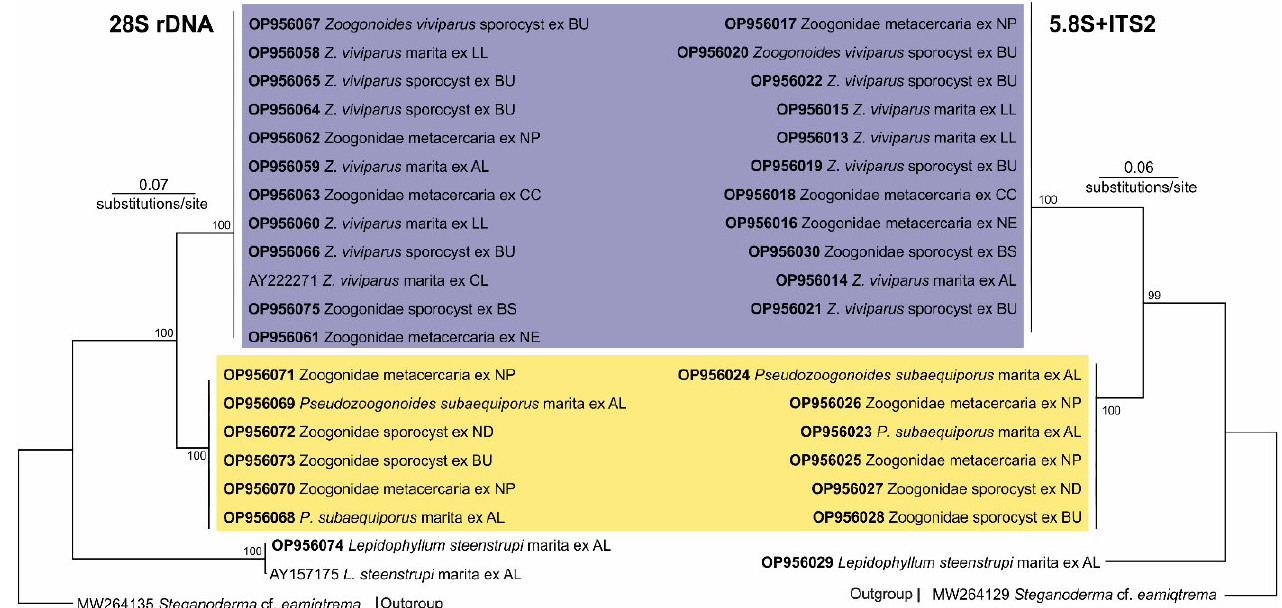
Figure 1. Maximum likelihood phylogenetic trees based on the 28S and 5.8S+ITS2 rDNA sequence data. Bootstrap values are printed in nodes. GenBank accession numbers of newly generated se ‐ quences are indicated in bold. Blue and yellow squares mark life cycle stages of Zoogonoides viviparus and Pseudozoogonoides subaequiporus , respectively. Scale bar shows the substitution rate. Abbrevia ‐